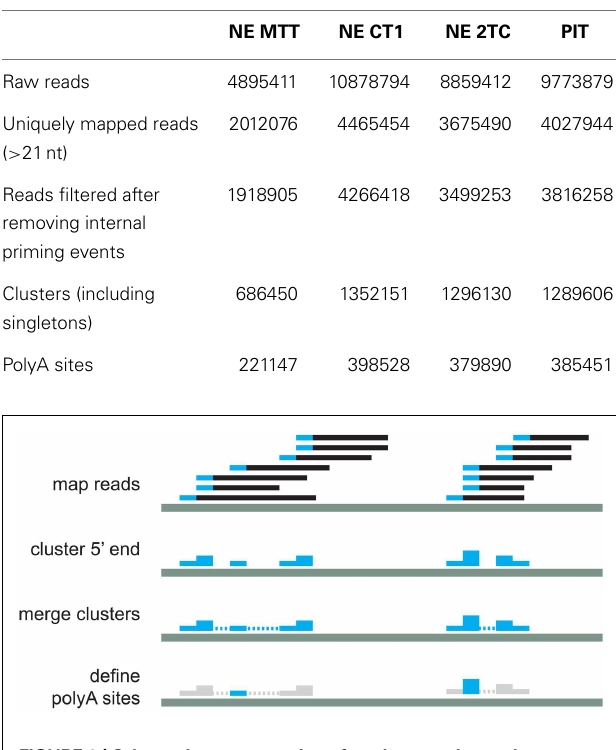
FIGURE 2 | Schematic representation of read processing and clustering